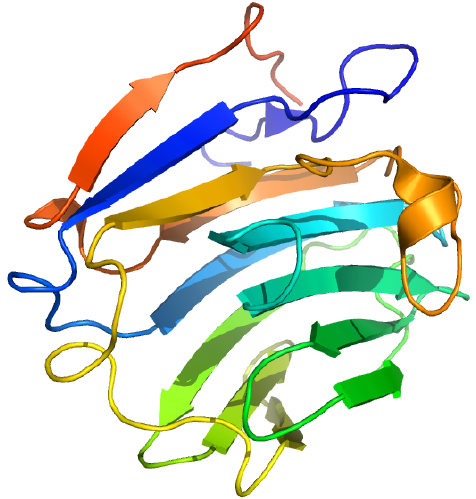
Figure 10. Crystal structures of the human sex hormone-binding globulin. The illustration was produced by PyMol using the atomic coordinates from the Protein Data Bank, PDB1KDK